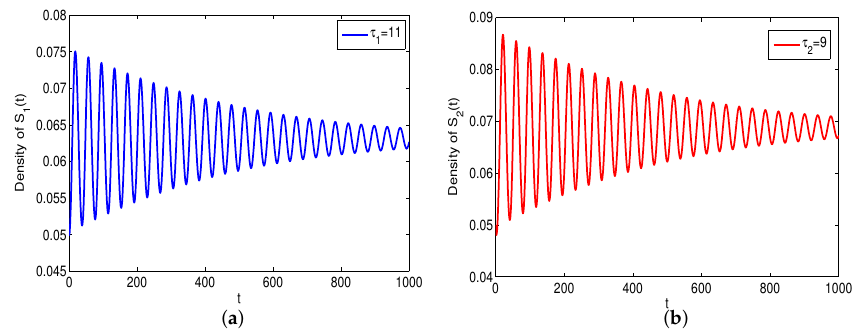
Figure 15. ( a ) The trajectory of S 1 ( t ) with τ 1 = 11. ( b ) The trajectory of S 2 ( t ) with τ 2 = 9.